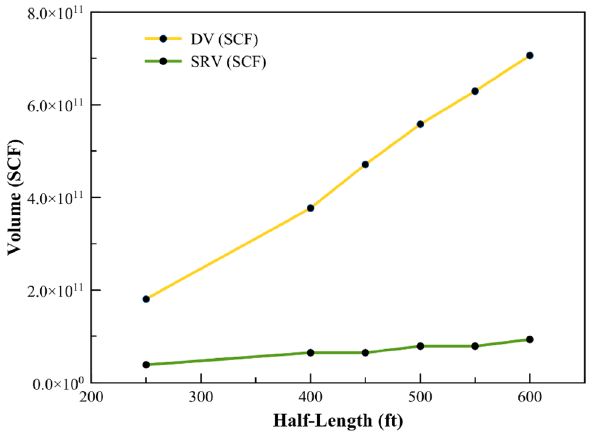
Fig. 11 SRV–DV Comparison of fracture half-length sensitivity